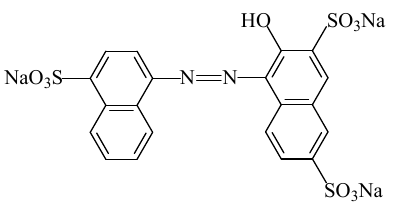
Figure 19. Structure formula of the amaranth colourant (E123).